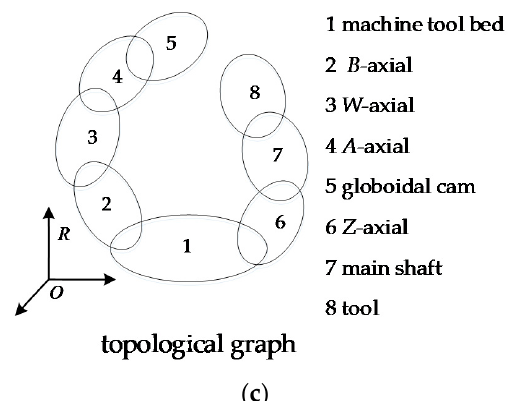
Figure 2. Special machine tool for globoidal cam and establishment of coordinate system. ( a ) The special machine tool for globoidal cam; ( b ) Machine tool structure; ( c ) Machine tool kinematics. According to the theory of multi-body system, there are two branches of machine tools: (1) tool branch; (2) workpiece branch, as shown in Figure 2c . There are three linear displacement errors and three angular displacement errors in the machine tool spindle, i.e., A -axis, B -axis, Z -axis, and W -axis respectively. Due to the relative motion relationship between the cam rotation angle and the driven turntable rotation angle, it is also necessary to consider the cam rotation angle and the driven rotation angle, the error of the rotation angle of the turntable, and the center distance error of the cam shaft and the driven shaft.